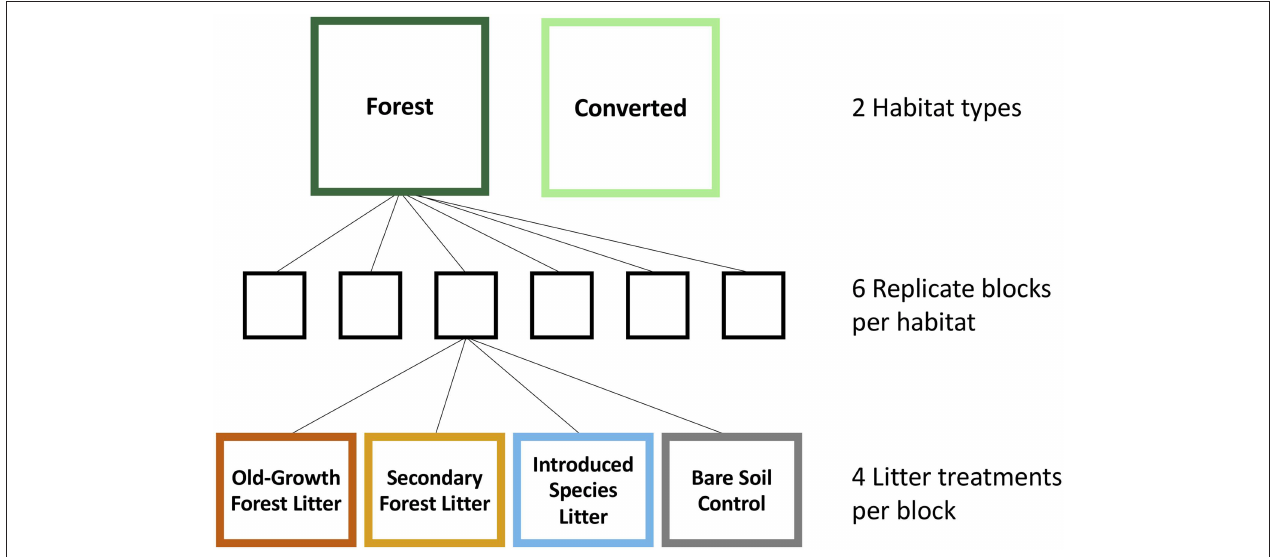
FIGURE 1 | Schematic diagram illustrating the set-up of a mesocosm experiment carried out in Malaysia and Panama, showing the two habitat types: forest and converted habitat, the six replicate blocks and the four litter treatments: old-growth forest, secondary forest, introduced species, and no litter (bare soil control).